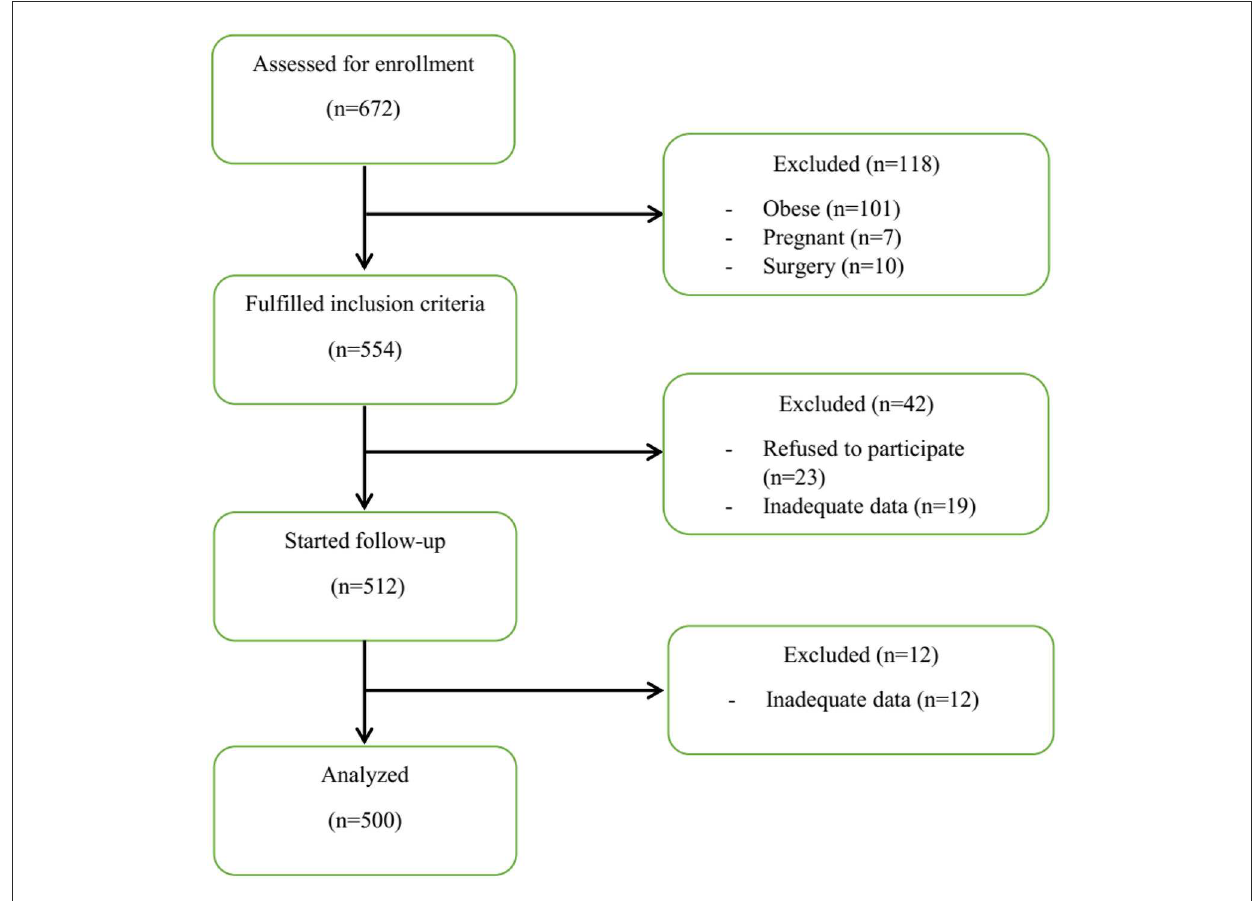
FIGURE1 Overview of the